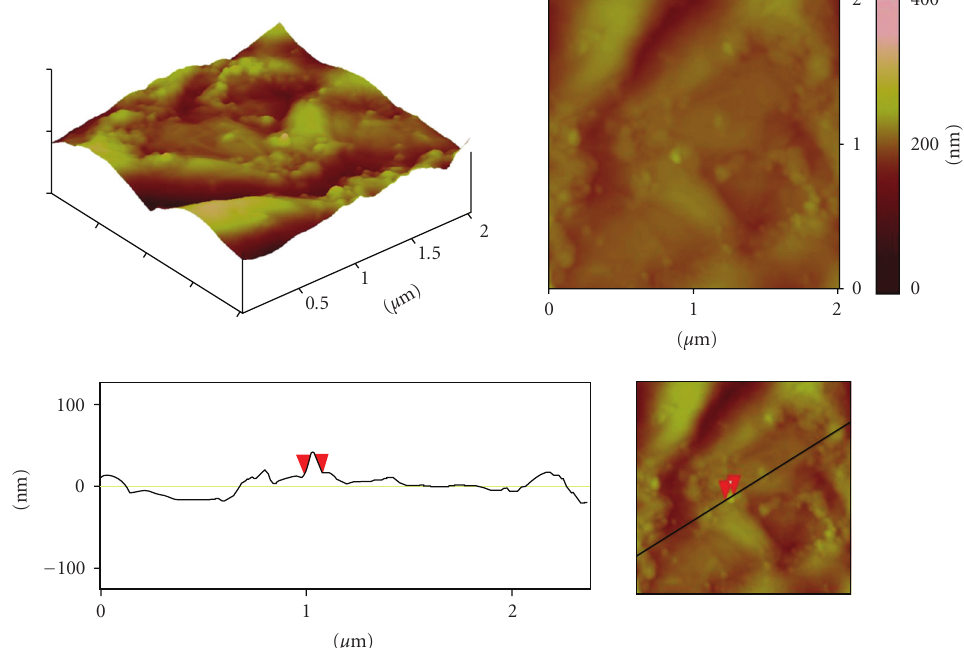
Figure 43: 3D and 2D AFM images of L-threonine crystal irradiated at 1.5 × 10 14 e/cm 2 .